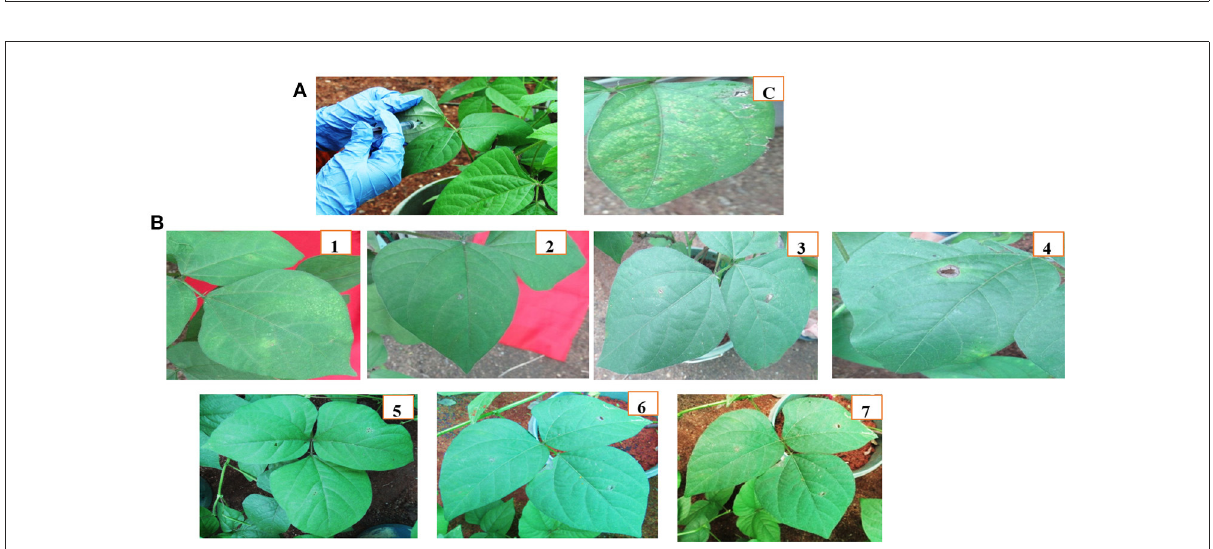
FIGURE6 Disease Phenotype of Vigna radiata (Greengram) plants of T 2 in distal leaves through Agroinfiltration: (A) Infiltrate MYMV clone using a needleless syringe into control and transgenic plants, C- Control greengram leaves showing MYMV disease symptoms within 20 dpi, (B) CRISPR challenged T 2 plants 1–7, the Infiltrated area showing symptoms within 20